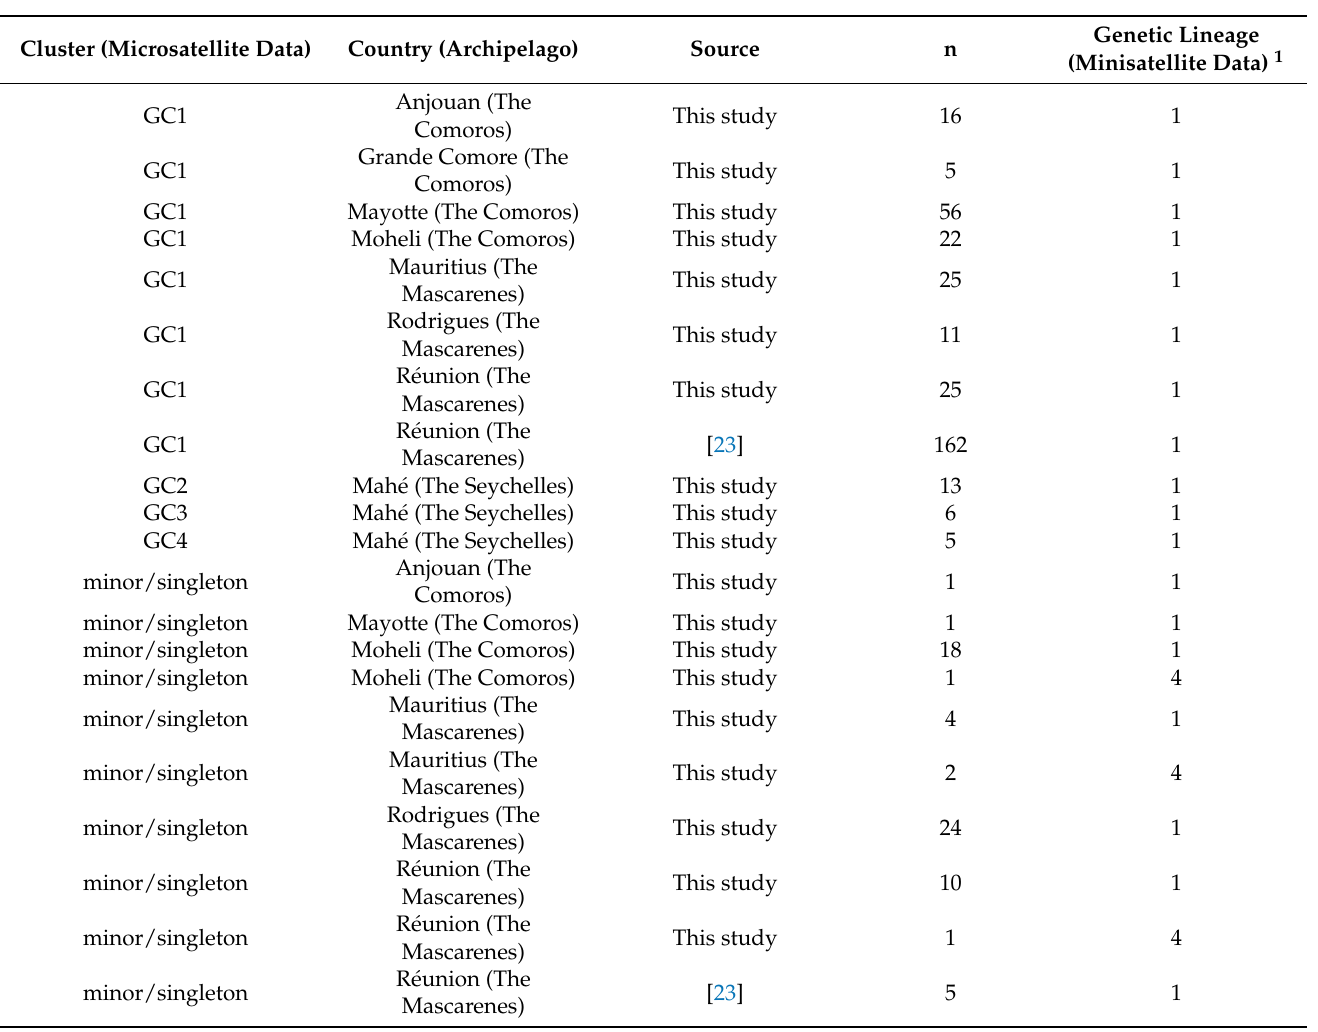
Table 2. Genetic cluster and genetic lineage assignation of strains of Xanthomonas citri pv. citri originating from the SWIO region based on microsatellite and minisatellite genotyping data, respectively.